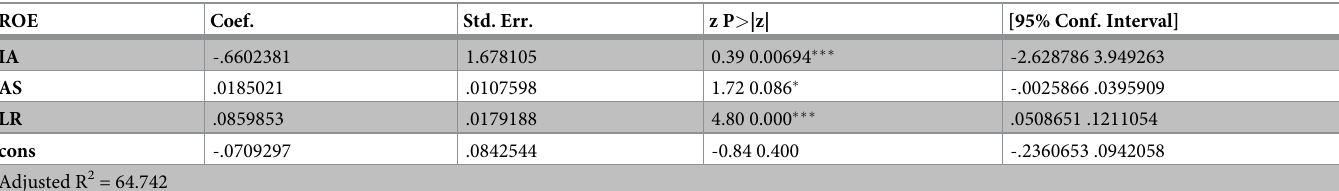
Table 7. Regression result -REM Model